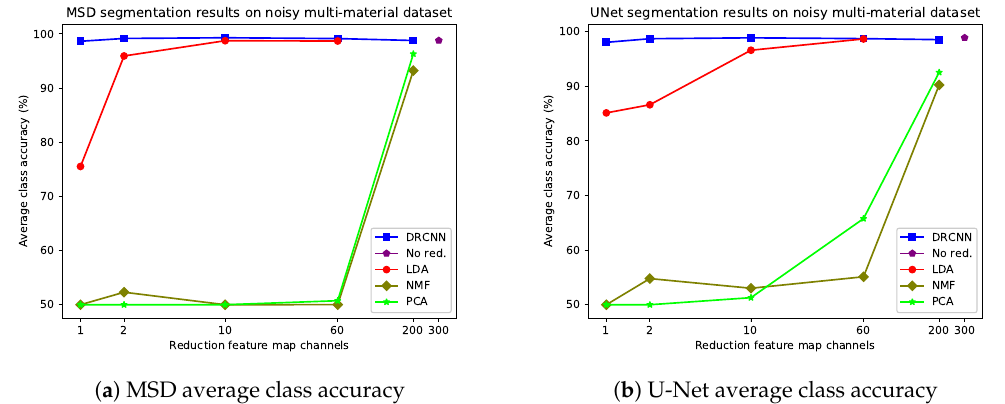
Figure 13. Average class accuracies for different data reduction methods using MSD ( a ) and U-Net ( b ) on the noisy multi-material X-ray dataset. As a reference, the results for standard MSD and U-Net net are included, which act directly on all 300 spectral bins.